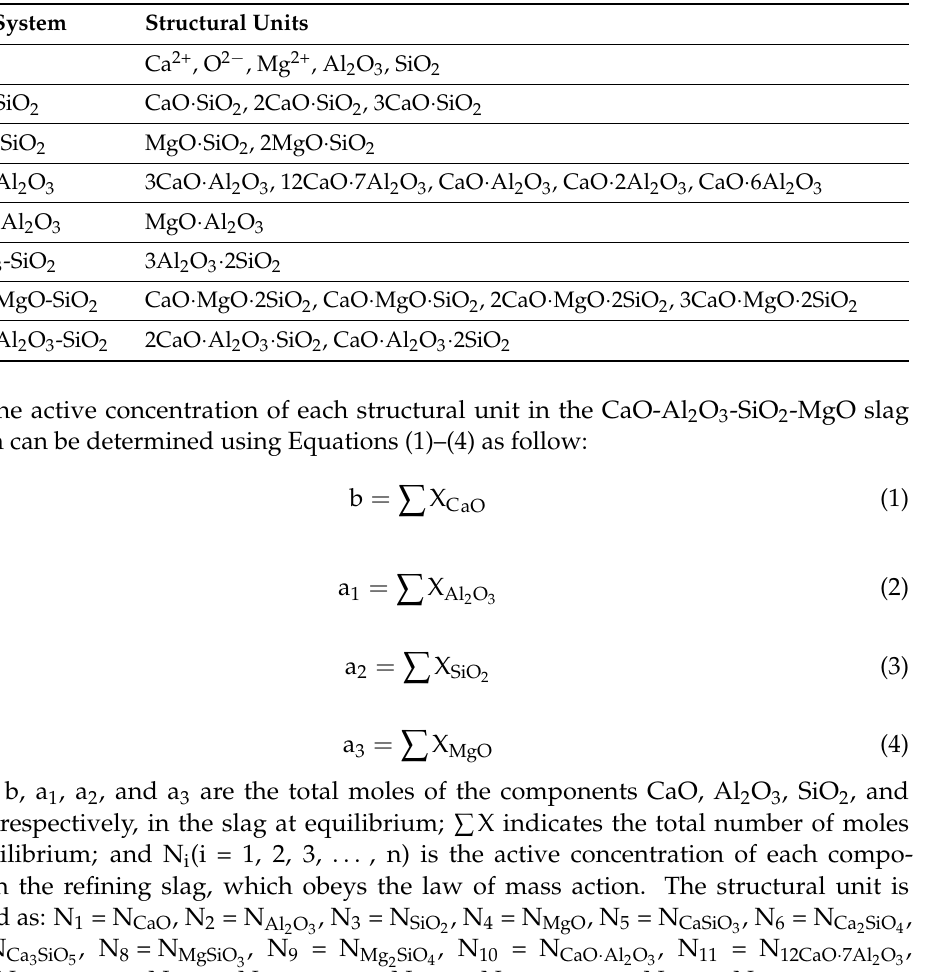
Table 1. Structural units present in the CaO-Al 2 O 3 -SiO 2 -MgO system.